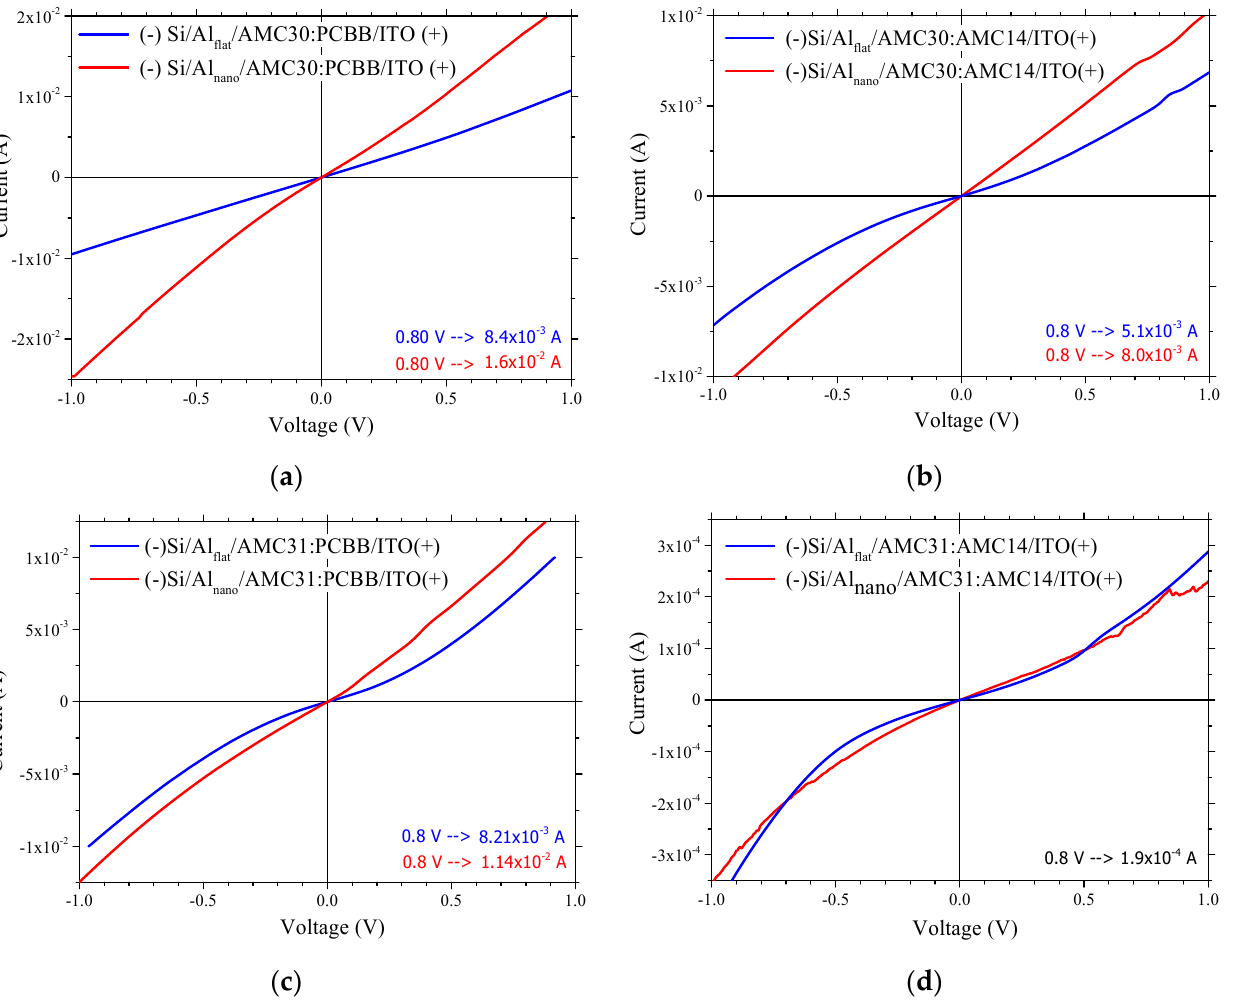
Figure 10. I-V characteristics in dark for the heterostructures prepared on Al flat and Al nano with the following bulk heterojunctions: AMC30:PCBB ( a ); AMC30:AMC14 ( b ); AMC31:PCBB ( c ); AMC31:AMC14 ( d ). Polarization is indicated in the figures.